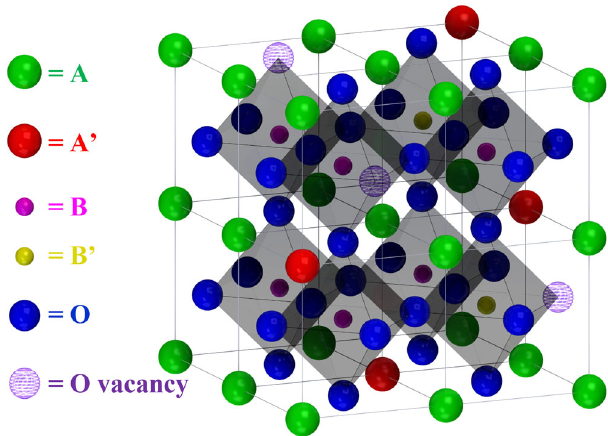
Fig. 1 The schematic drawing of the crystal structure of fractionally doped perovskites. The chemical formula of fractionally doped perovskites is A x A ’ 1-x B y B ’ 1-y O 3- δ , where 1 ≥ x ≥ 0, 1 ≥ y ≥ 0 and 3- δ represents oxygen